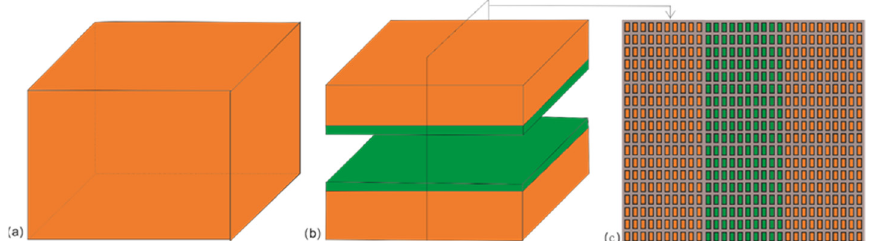
Figure 6. The schematic showing the partitioned computational space in the depth direction: ( a ) the entire computational domain; ( b ) two parts of the computational domain which are partitioned in the z direction, with an overlapped domain; ( c ) slices displayed in the z direction.